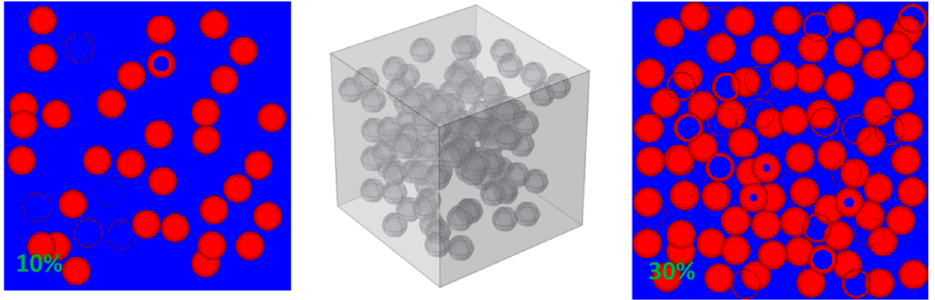
Figure 1. Two-dimensional and three-dimensional RSA Model (10 vol.% on the left and 30 vol.% on the